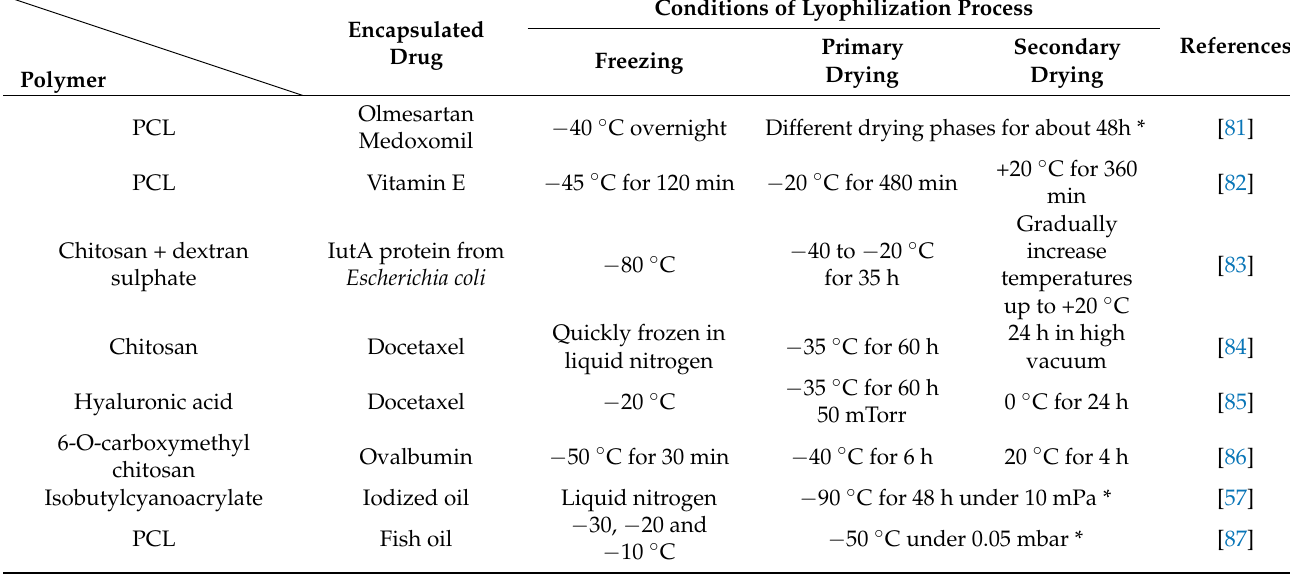
Table 4. Examples of freeze-dried nanocapsules and process